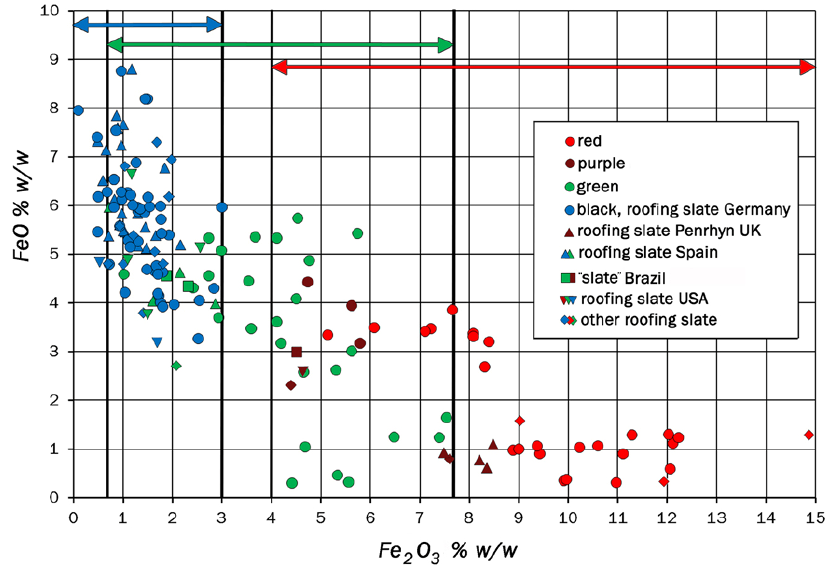
Figure 1. The dependency of slate color on the Fe 2 O 3 /FeO ratio (analyses from [6,16,18–20] and own data).